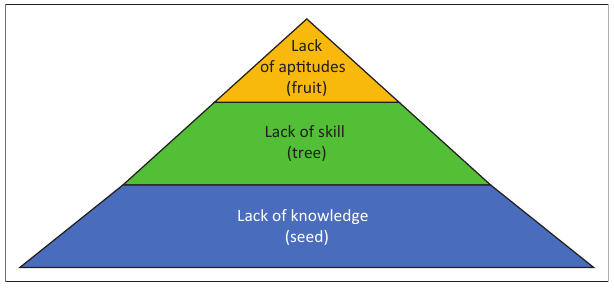
FIGURE 2: Entrepreneur